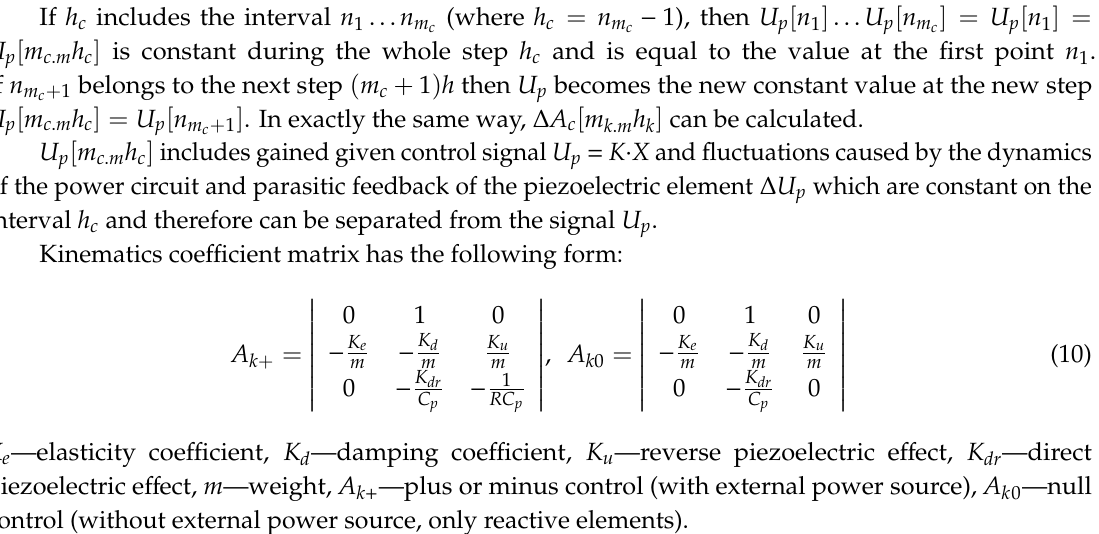
Figure 7. Model with calculation of parameters on the constancy intervals.